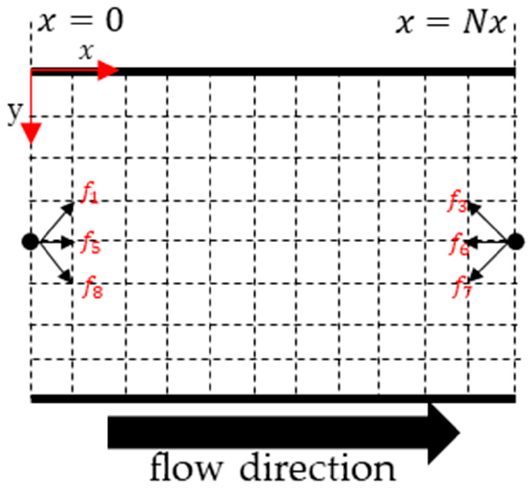
Figure 2. Open flow boundary.